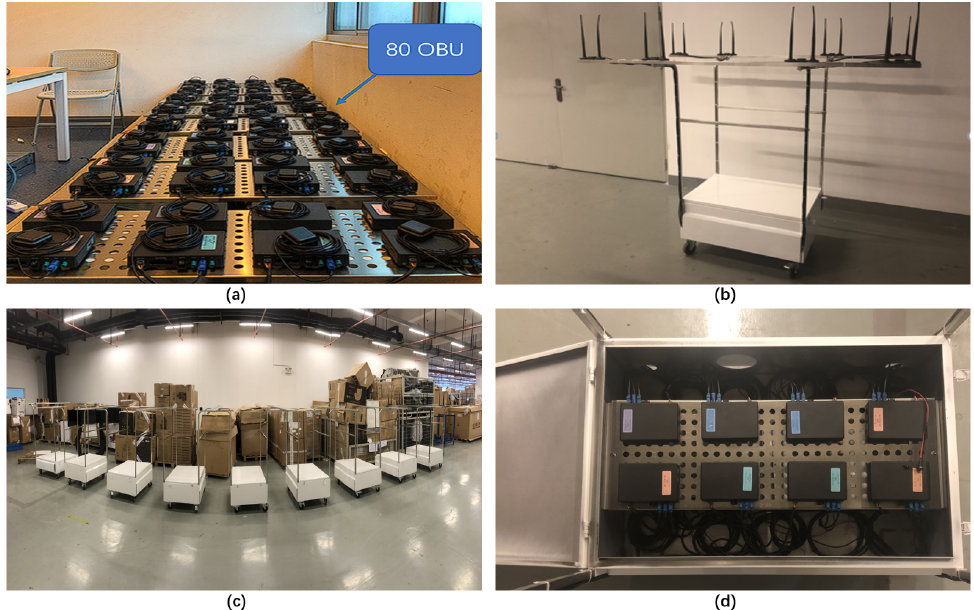
Figure 22. ( a ) 80 OBU for indoor testing, ( b ) background vehicle, ( c ) 8 background vehicles, ( d ) Box of the vehicle and 8